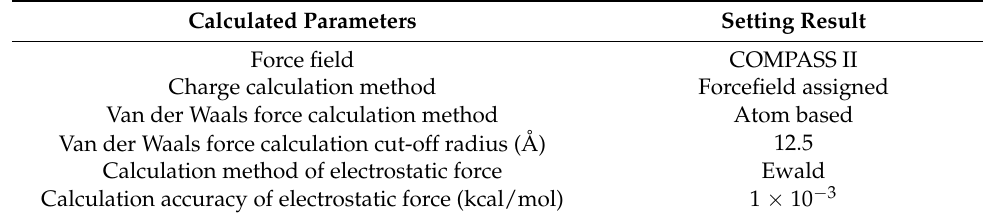
Table 2. Setting of relevant parameters for energy